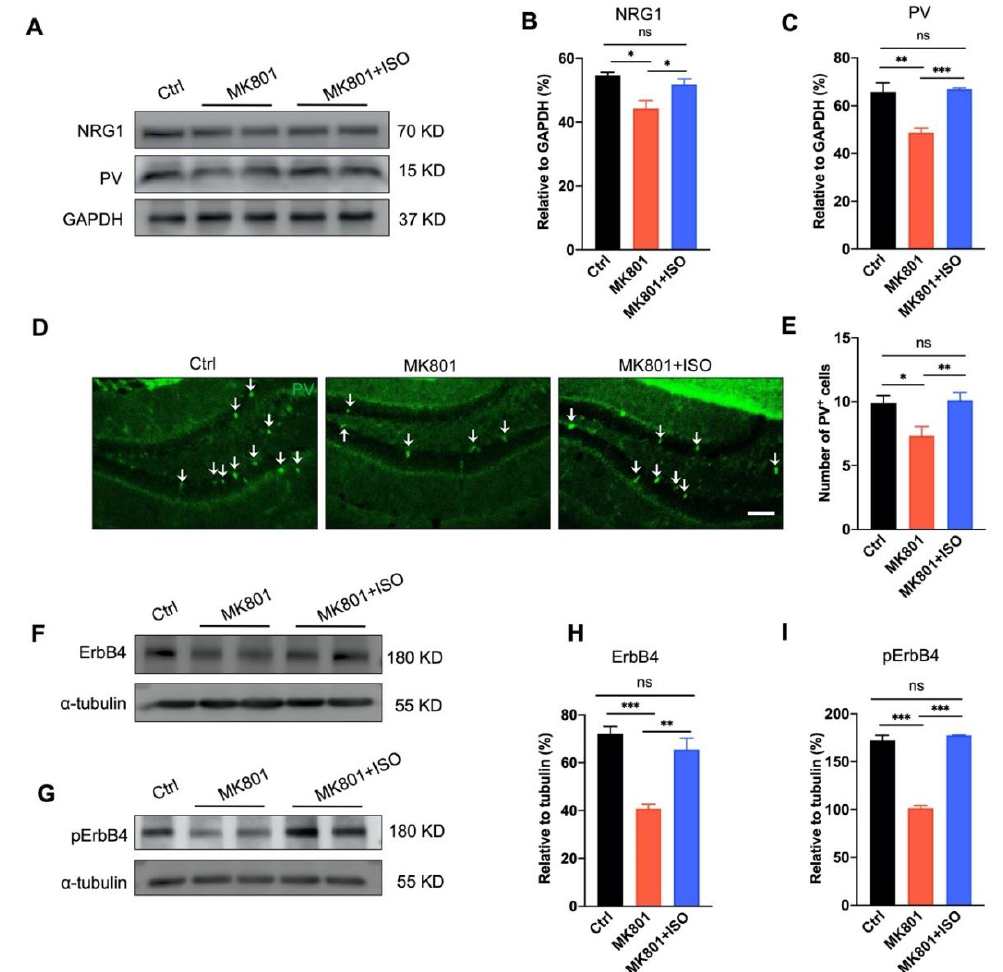
Figure 4. Isoflurane reverses MK801’s effects on PVIs reduction and NRG1-ErbB4 signaling down- regulation in the DG. ( A ) Representative Western blotting image of NRG1 and PV in the DG. GAPDH served as loading control. ( B , C ) Quantification of NRG1 and PV expression in A. Isoflurane reversed MK801 induced NRG1 and PV reduction in the DG ( n = 3 mice per group. one-way ANOVA, F (2, 9) = 8.508, p = 0.0084; post hoc test: Ctrl vs. MK801, p = 0.0082; MK801 vs. MK801+ISO, p = 0.048; Ctrl vs. MK801+ISO, p = 0.19 shown on B; one-way ANOVA, F (2, 9) = 16.71, p = 0.0009; post hoc test: Ctrl vs. MK801, p = 0.0072; MK801 vs. MK801+ISO, p < 0.0001; Ctrl vs. MK801+ISO, p = 0.78 shown on ( C )). ( D ) Representative photomicrographs showing PV-positive cells in the DG. Scale bar, 100 μm. ( E ) Quantification of PV neuron number in ( D ). Isoflurane reversed MK801 induced the reduction of PV-positive neuron number in the DG (five mice in each group and five sections in each animal were picked, and three cells of each section were analyzed and counted. One-way ANOVA, F (2, 24) = 5.863, p = 0.0084; post hoc test: Ctrl vs. MK801, p = 0.013; MK801 vs. MK801+ISO, p = 0.009; Ctrl vs. MK801+ISO, p = 0.796). ( F , G ) Representative Western blotting images of ErbB4 and phosphorylated-ErbB4 in the DG. α -tubulin served as loading control ( n = 3 mice per group). ( H , I ) Quantification data of ErbB4 and phosphorylated-ErbB4 expression in the DG. Isoflurane reversed MK801 induced the reduction of ErbB4 and phosphorylated-ErbB4 in the DG. One-way ANOVA, F (2, 9) = 22.48, p = 0.0003; post hoc test: Ctrl vs. MK801, p = 0.0001; MK801 vs. MK801+ISO, p = 0.001; Ctrl vs. MK801+ISO, p = 0.298 shown on ( H ); One-way ANOVA, F (2, 9) = 8152.9, p < 0.0001; post hoc test: Ctrl vs. MK801, p < 0.0001; MK801 vs. MK801+ISO, p < 0.0001; Ctrl vs. MK801+ISO, p = 0.3566 shown on ( I ). Data are represented as mean ± SEM, two-tailed Student’s t -test, * p < 0.05, ** p < 0.01, *** p < 0.001, ns, not